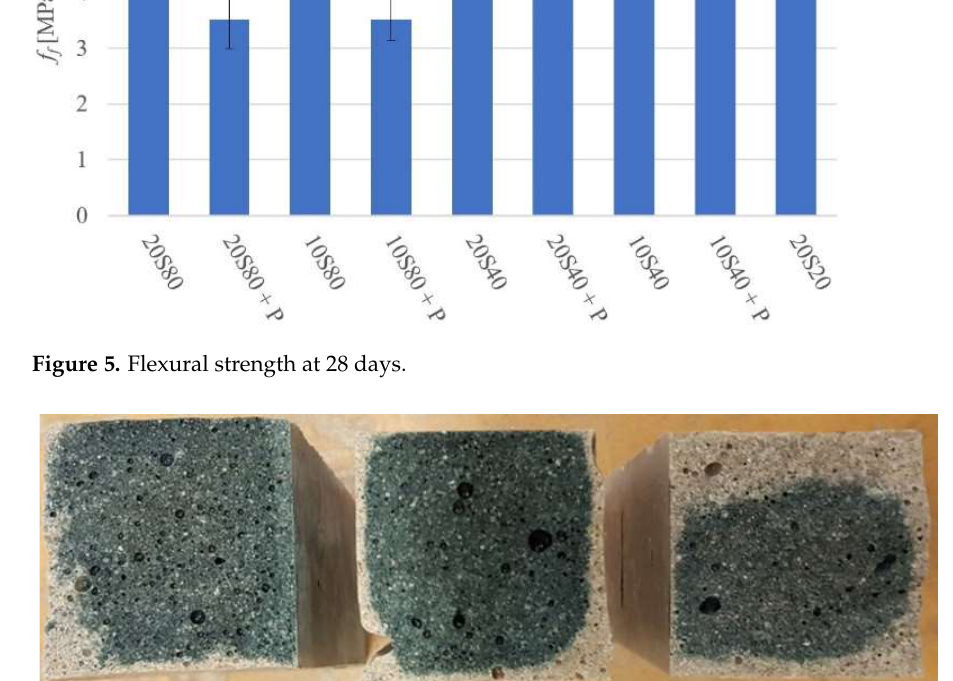
Figure 6. Cross sections of specimens (from left: mortars 20S20, 20S40, and 20S80).